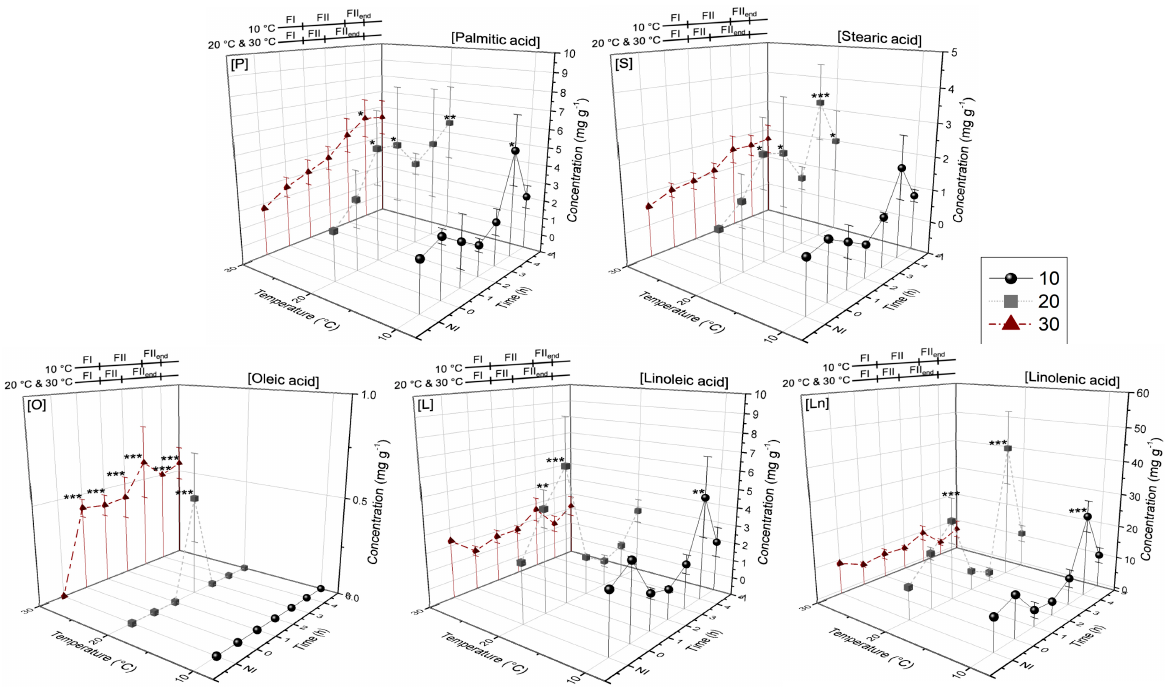
Figure 4. Fatty acid concentration changes in S. hispanica seeds related with imbibition stages (FI, FII and FII end ) at 10, 20 and 30 °C. Concentrations were calculated relative to the weight of non-imbibed seeds (NI) within the total weight. Values are expressed as mean ± SD of three independent replicates. Statistical analysis was performed using two-way ANOVA followed by a Dunnett multiple comparison test. Asterisks correspond to data with statistical differences regard with control concentration in NI (* p = 0.033; ** p = 0.002; *** p < 0.001).